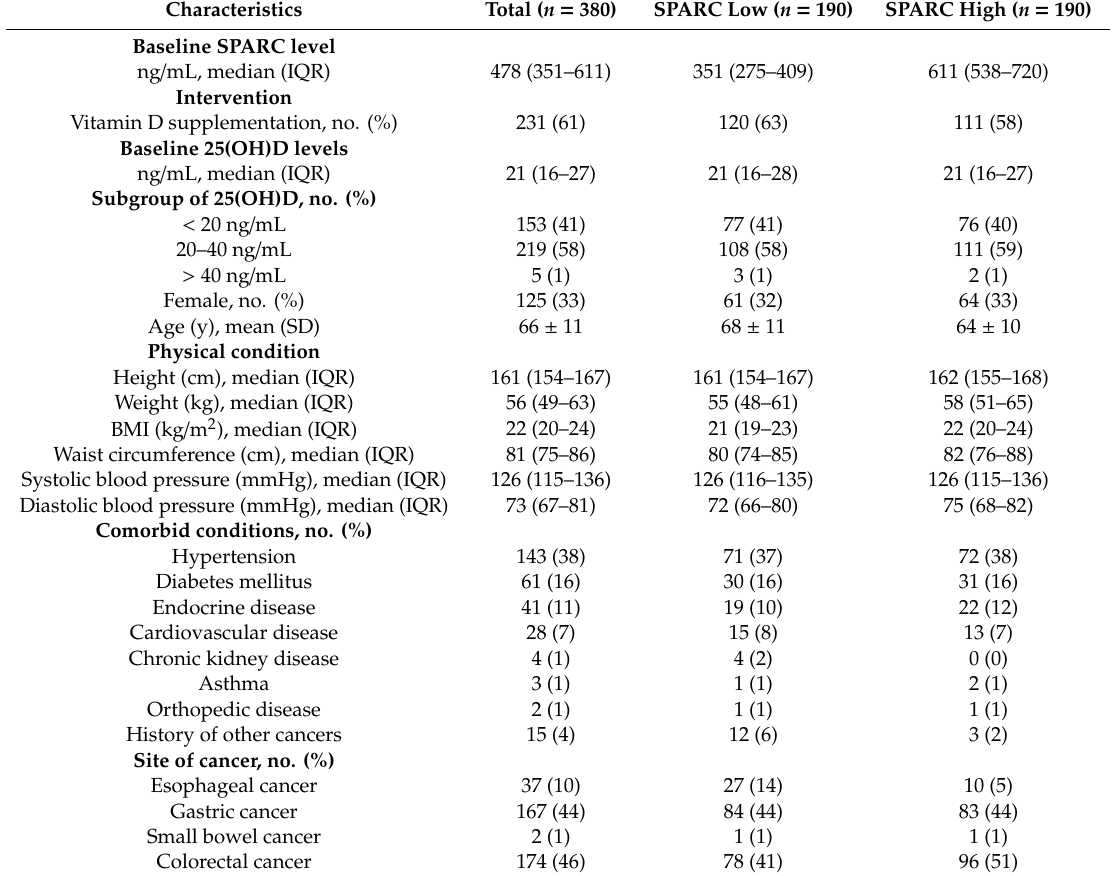
Table 1. Patient demographic characteristics of all patients and the two groups divided by median serum SPARC